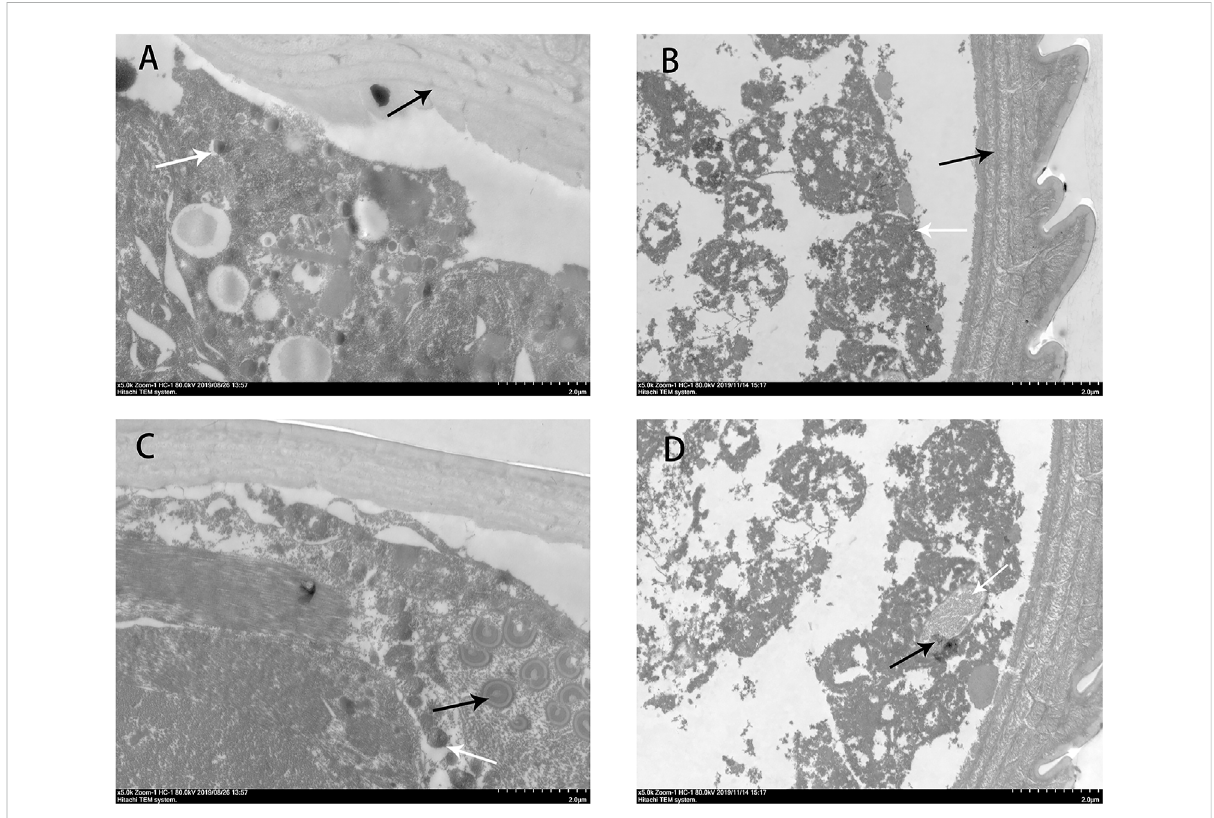
FIGURE 3 The effect of benzoic acid -2- benzyloxy - 3,4 - tetrahydrofuran diester on S. scabiei mite body wall after 1 h. The control group (A) epidermis body walls, the dermatoglyph of waves can see, the nucleus of the corium layer was integrated (×2550). The experimental group (B) epidermis body walls, the dermatoglyph of waves becomes smooth, the nucleus meltdown (×2550). The control group (C) I-type cells of body cavity, the nucleus was located in cell edge, cytoplasm contained lipid droplets, mitochondria (×6000). The experimental group (D) I-type cells of body cavity, the nucleus meltdown, mitochondria damage